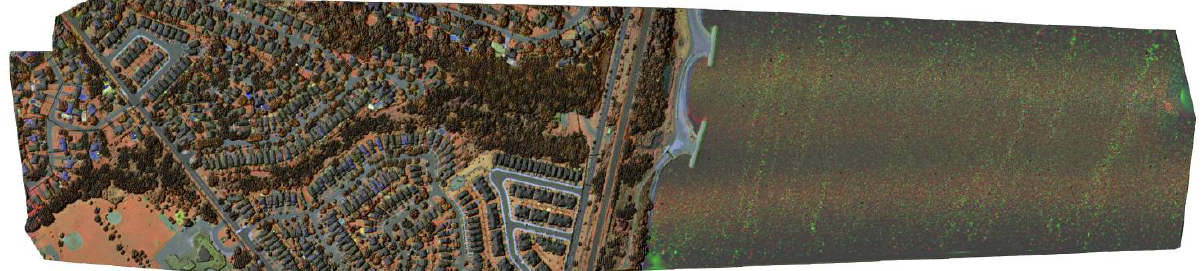
Figure 1. Test area: colour composition of multispectral laser scanning intensity (R-NIR, G-SWIR, B-G) overlaying the shaded digital surface